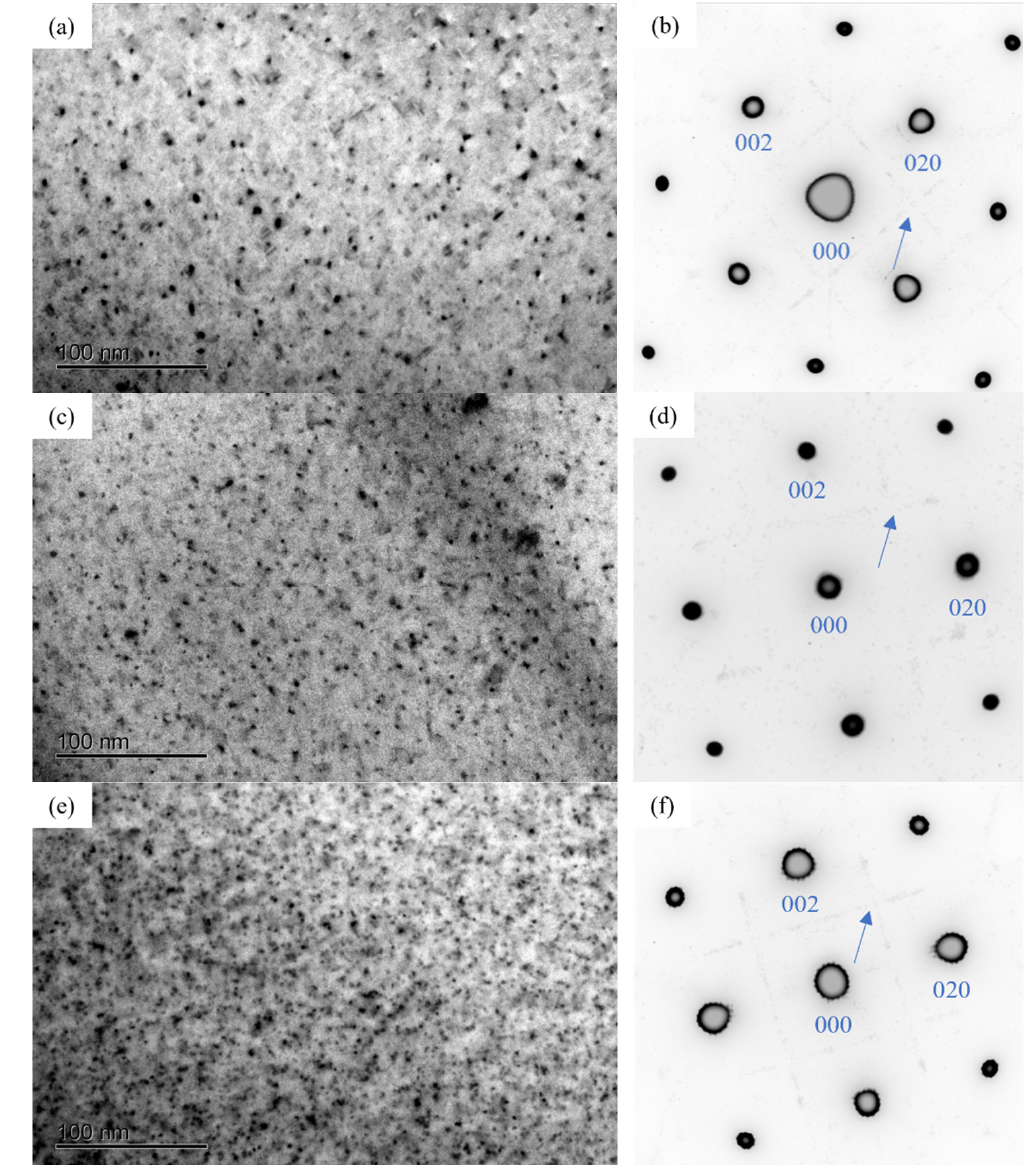
Figure 4. Bright field (BF) image and selected area electron diffraction (SAED) patterns of the alloy after initial aging at 175 °C for 0.5 h of three alloys. ( a , b ) 0Cu alloy; ( c , d ) 0.18Cu alloy; ( e , f ) 0.37Cu alloy.